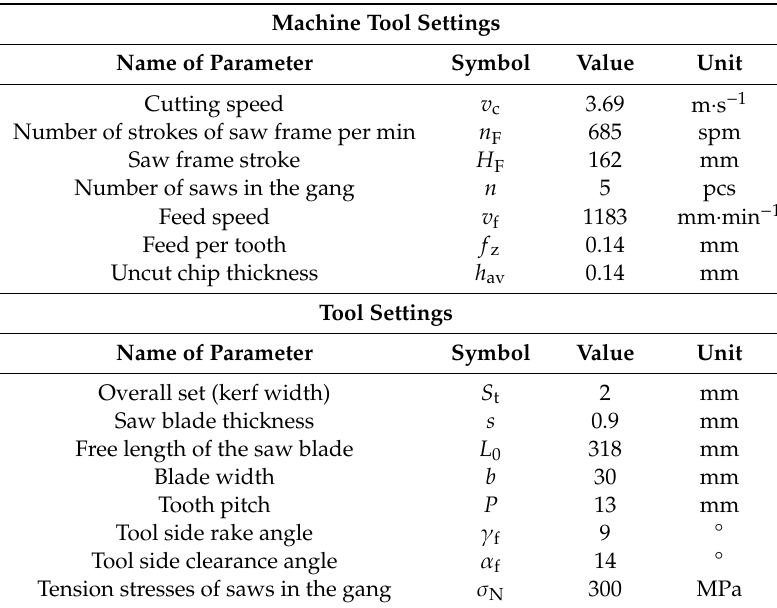
Figure 2. Mode sawing kinematics on the sash gang saw: fz–feed per tooth, s–saw blade thickness, AD–area of the cut, P–pitch, Y, Z and YM, ZM–machine coordinate and setting axes, Yf–f-set coordinate axis, Pfe–working plane. Table 2. Machine tool and tool settings for frame sawing process.